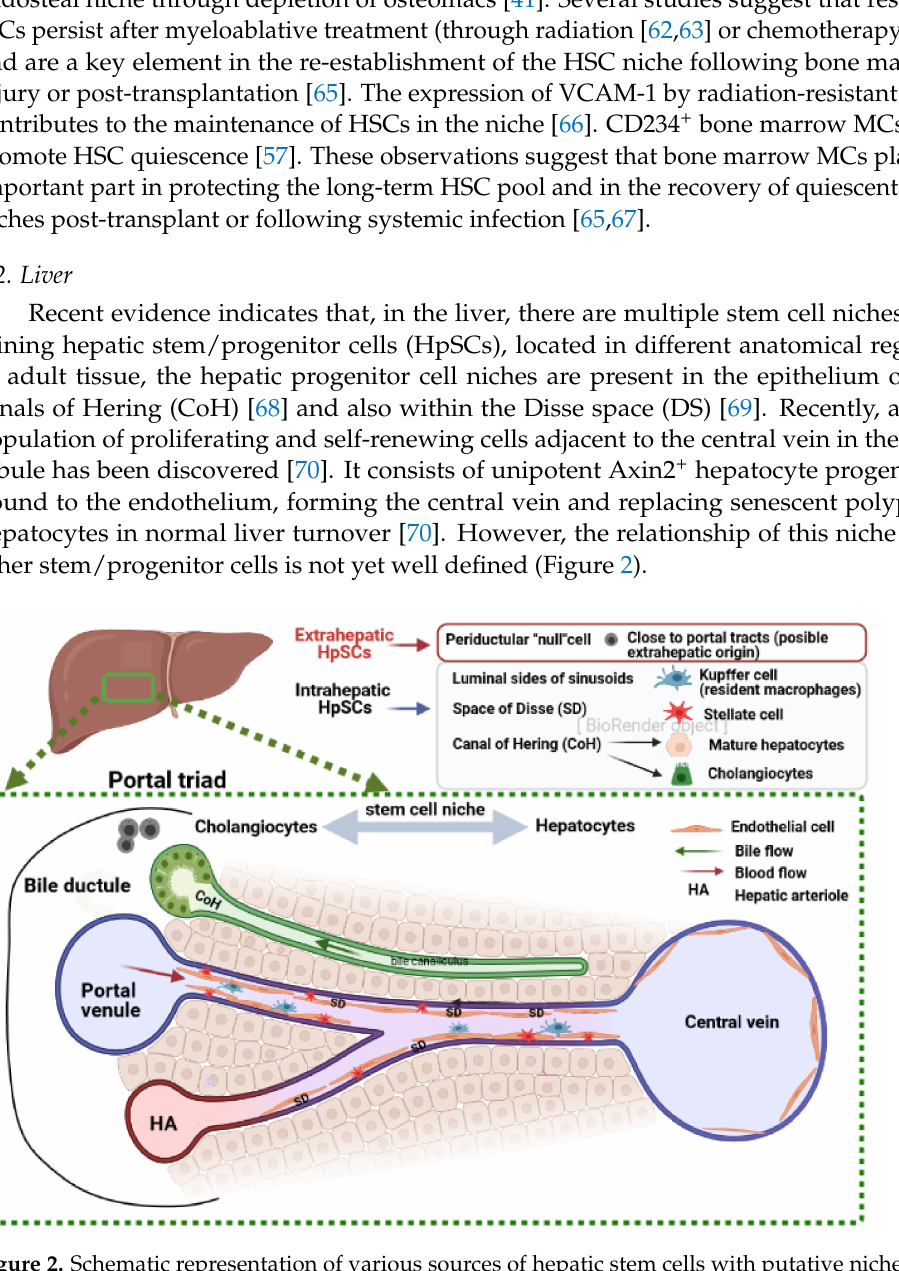
Figure 2. Schematic representation of various sources of hepatic stem cells with putative niches and their location within the liver. The portal triad consists of a portal venule, a bile ductule, and a hepatic arteriole. The blood in the portal venule and the hepatic arteriole flows between the hepatocytes to the central vein through sinusoids surrounded by sinusoidal endothelial cells. The bile secreted by hepatocytes is collected by a system of ducts. Four possible hepatic stem cell niches have been identified to date [71]. Three of them have intrahepatic localization: in the epithelium of the canals of Hering, space of Disse, and intralobular bile ducts. With extrahepatic origin, periductular “null” cells have been identified as a proximal niche [72]. Created with BioRender.com (accessed on: 7 March